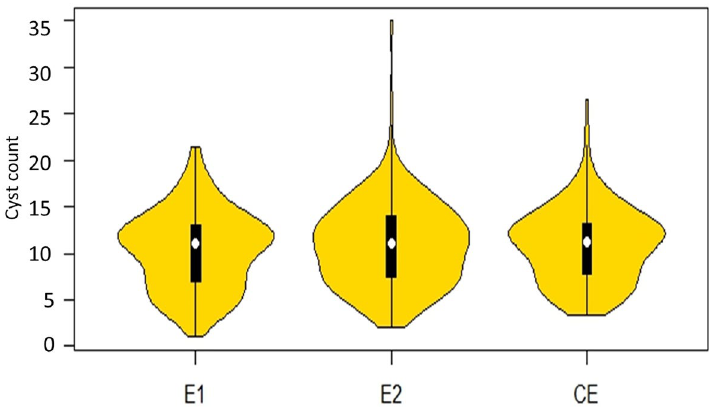
Figure 1. Violin plots of the distribution of cysts count in environment one (E1), environment two (E2) and the combined environment (CE). The vertical solid bar indicates the range of average values, and median is shown as a white circle, depicting the lower, medium and upper quartile.